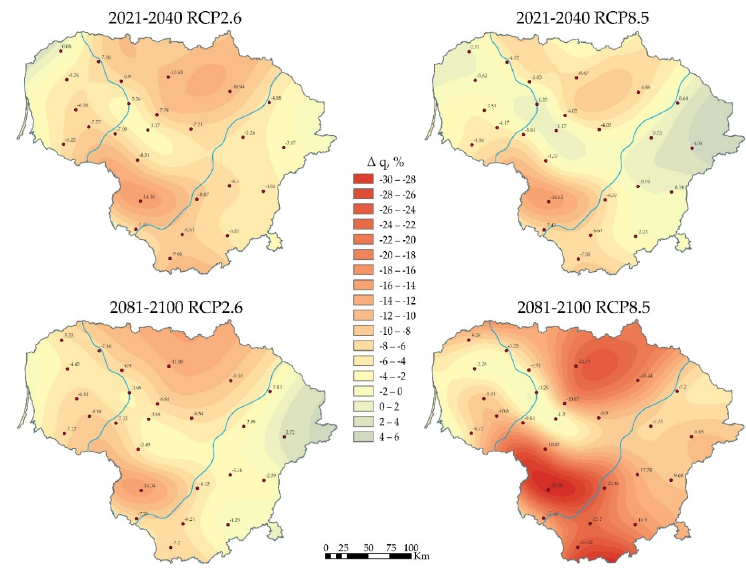
Figure 5. Changes (in %) of specific runoff in Lithuanian rivers in the 21st century relative to 1986–2005. Table 5. Kinetic resources of the main Lithuanian rivers (E KT , GWh a − 1 ) and projection of their changes (in %) in the near and far future relative to